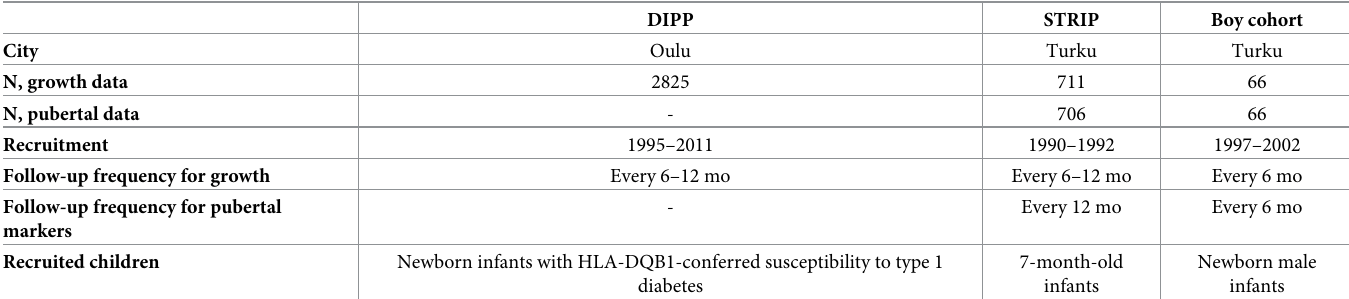
Table 1. Characteristics of the cohort